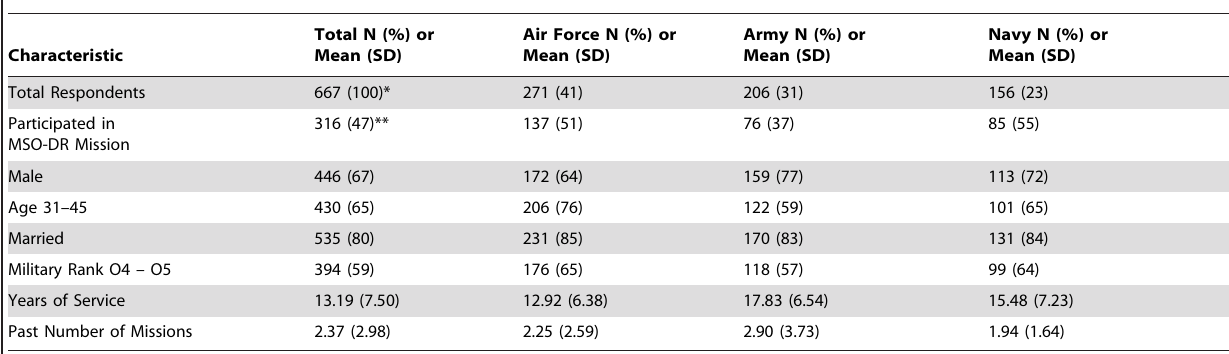
Table 1. Study sample